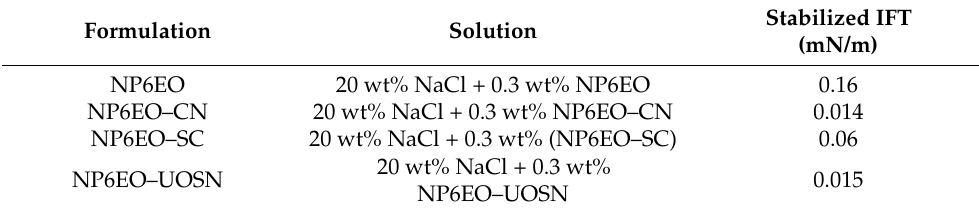
Figure 3. Dynamic interfacial tension between surfactant formulation and crude oil. Table 2. IFT of surfactant formulations as well as the water used to prepare